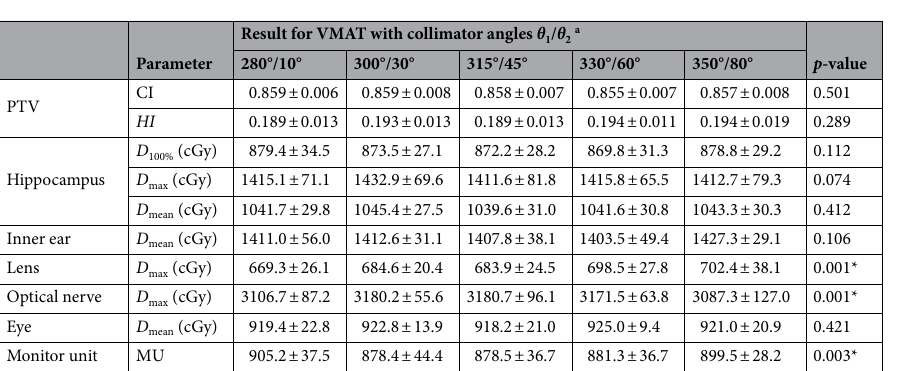
Table 3. Dosimetric parameters and MUs of Δ θ = 90° plans, along with their Friedman test results. a θ 1 and θ 2 indicate the collimator angles of arc 1 and arc 2, respectively. *Statistically significant ( p < 0.05).